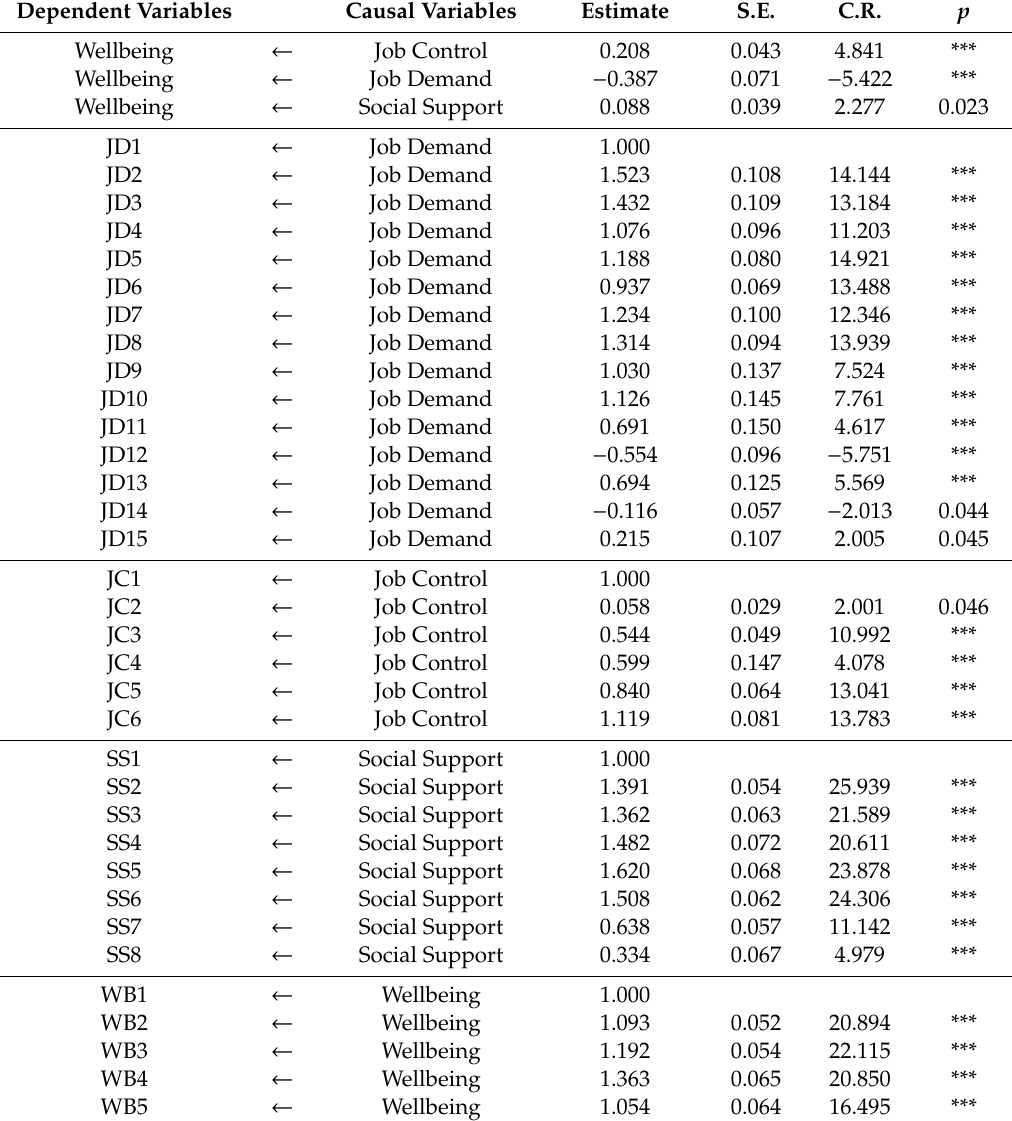
Table 4. Structural equation model (SEM) coe ffi cient estimates and tests.